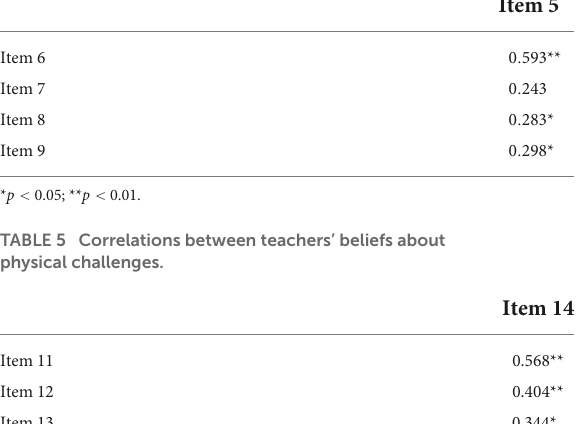
TABLE 4 Correlations between teachers’ beliefs about emotional challenges.